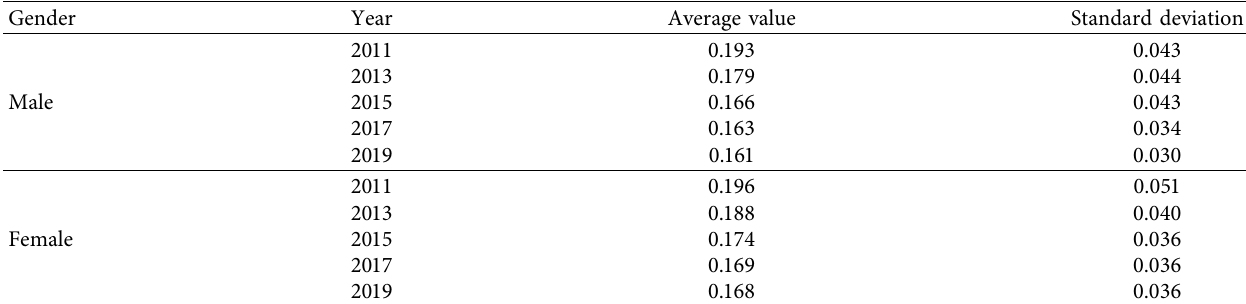
Table 2: The average value and standard deviation of the athlete’s reaction time each